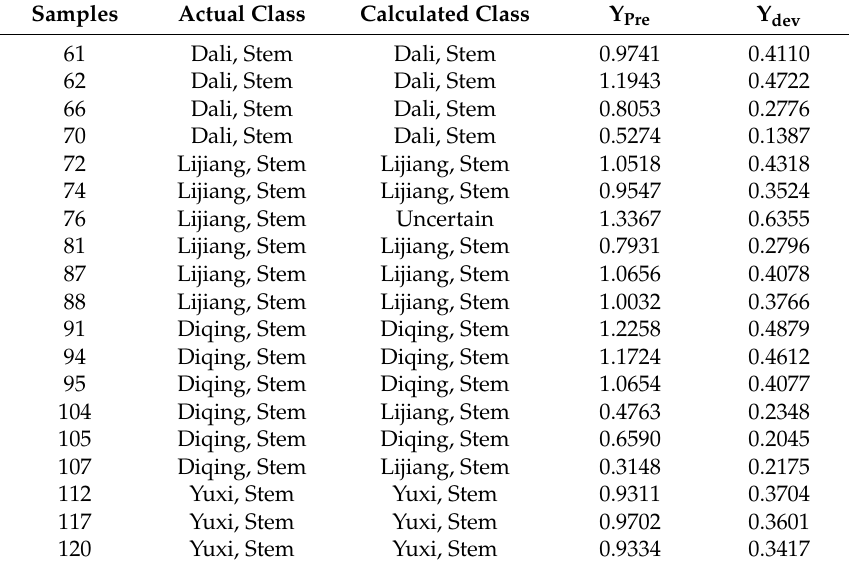
Table 3. Results of the PLS-DA model 2 validation set